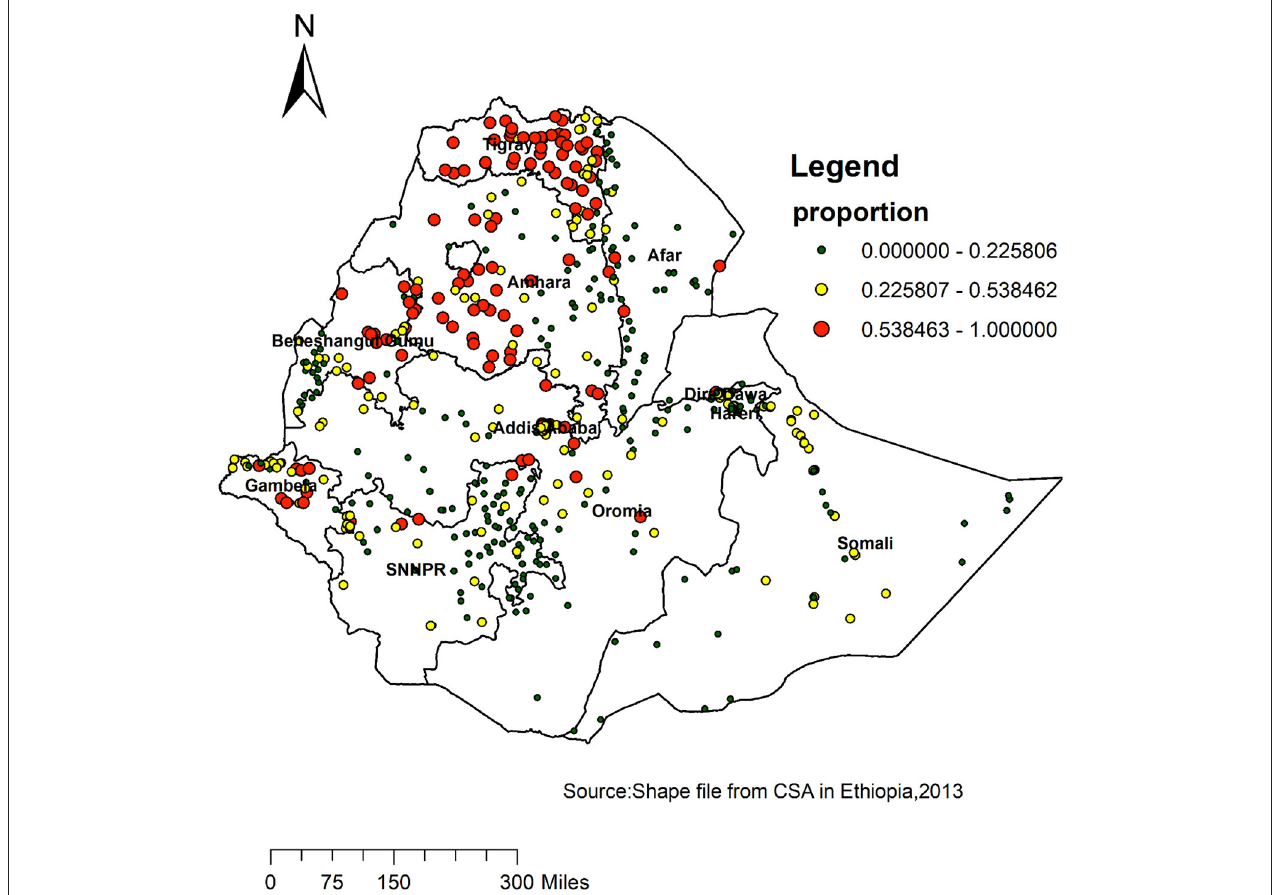
FIGURE 3 | Spatial distribution of risky health behavior among adult males across regions in Ethiopia,